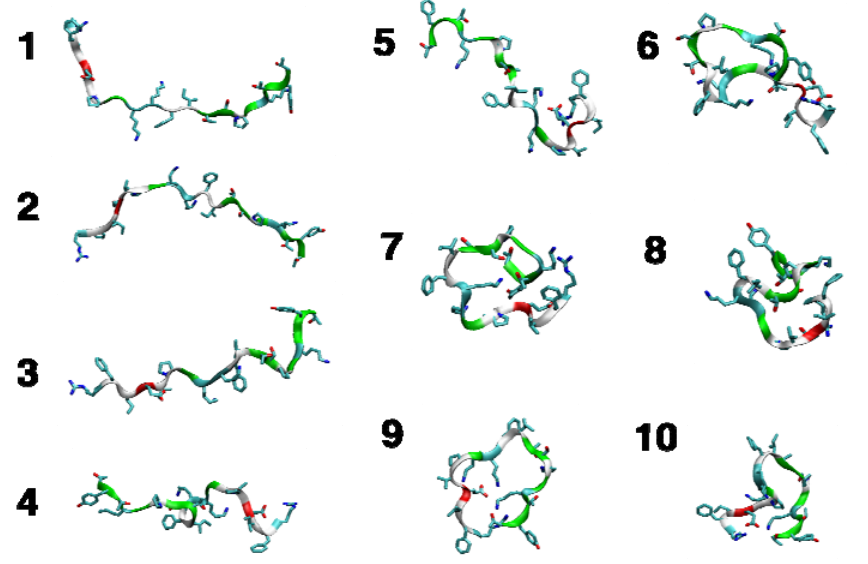
Figure 3. Ten different starting conformations taken from a high-temperature trajectory were used to seed the simulations.